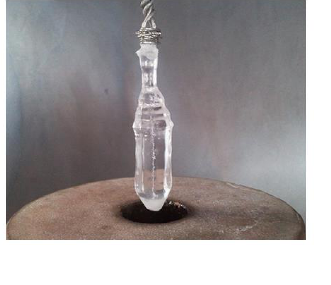
Fig. 1 Yb:LYSB as-grown crystal. Fig. 2 Laser pulse energy, E p vs. absorbed energy of the pump pulse, E abs . T is the out-coupling mirror